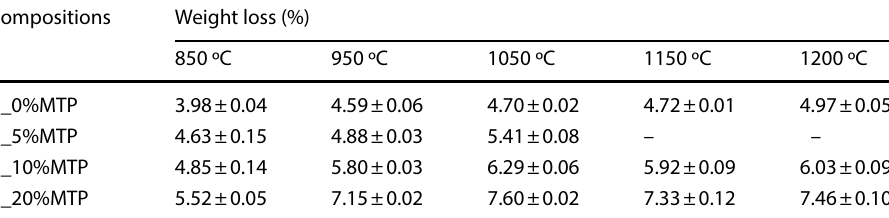
Table 7 Water absorption behavior with the increase of firing temperature